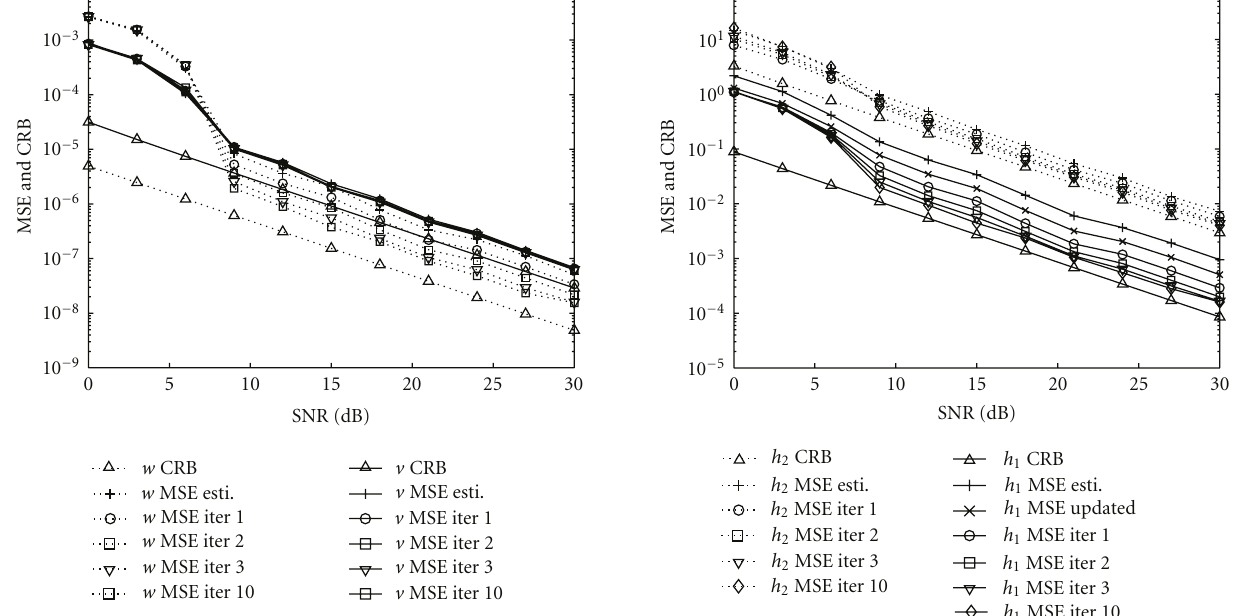
Figure 3: Channel estimation MSE versus SNR: N = 24.